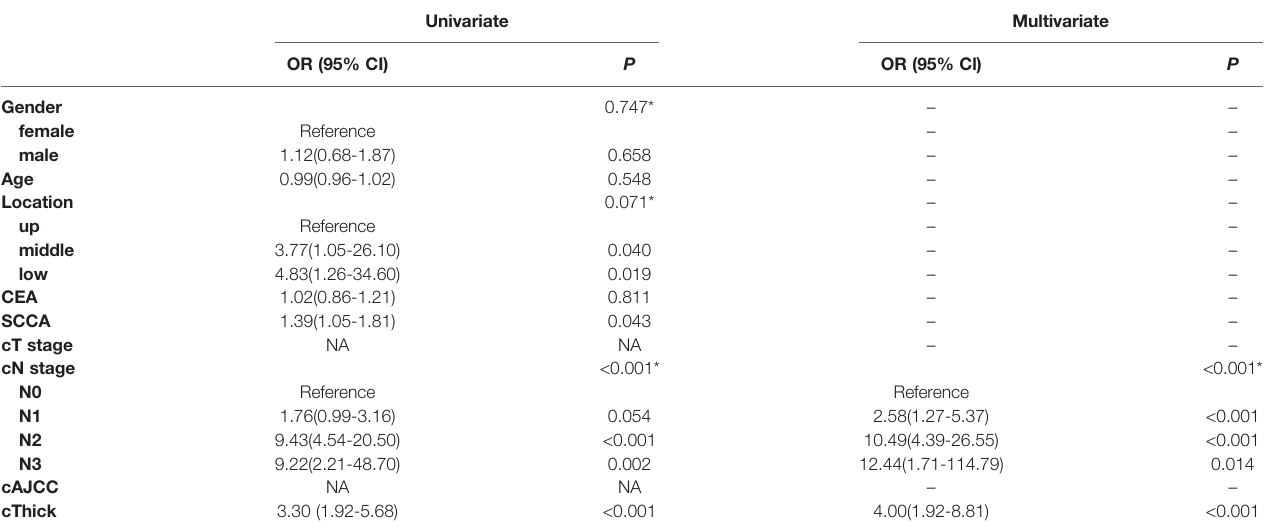
TABLE 2 | Univariate and Multivariate analysis to identify signi fi cant factors for